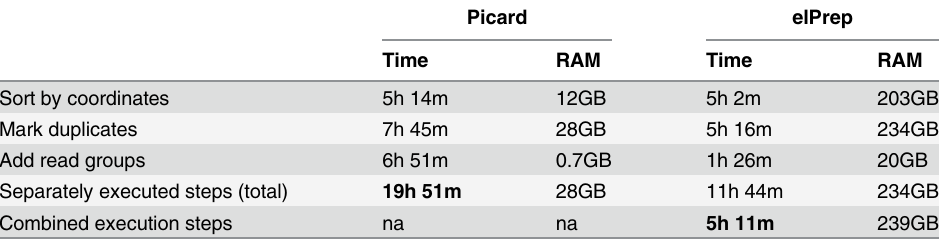
Table 5. Benchmarks of the 3-step pipeline on NA12878 whole genome (Support protocol 3). Picard elPrep Time